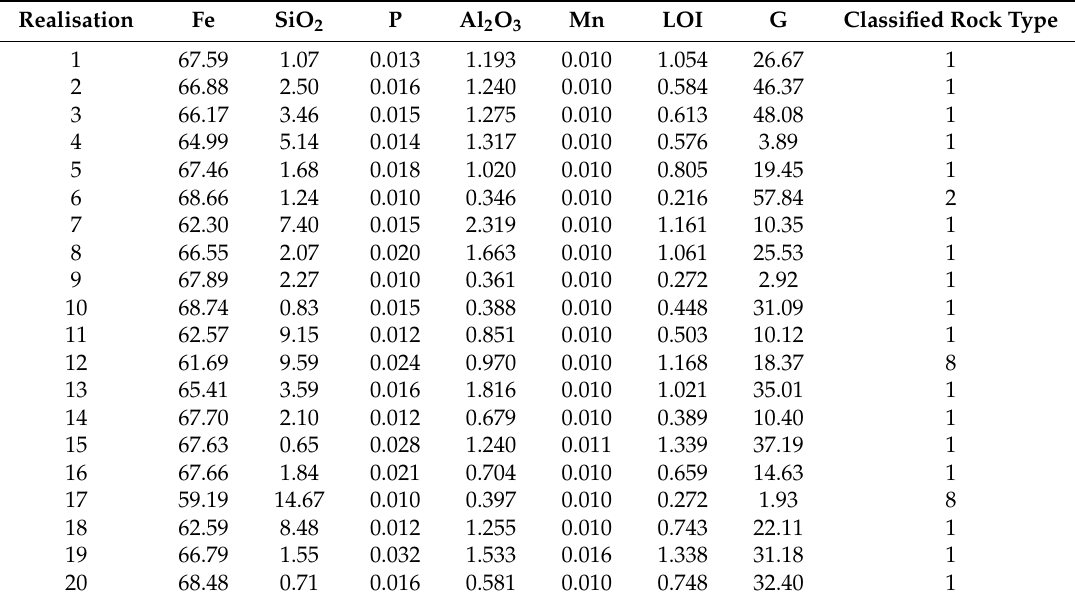
Table 8. Simulated grades and granulometry, and associated rock type, for 20 realisations of block n ◦ 2, interpreted as rock type 7 (friable iron-poor itabirite) by mining geologists.